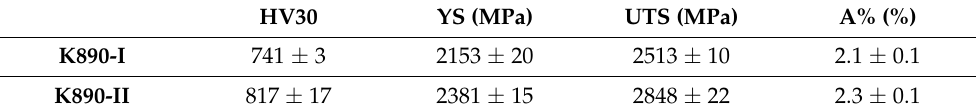
Table 2. Hardness and tensile properties (mean values and standard deviations) of the K890 steel subjected to K890-I and K890-II heat treatments.